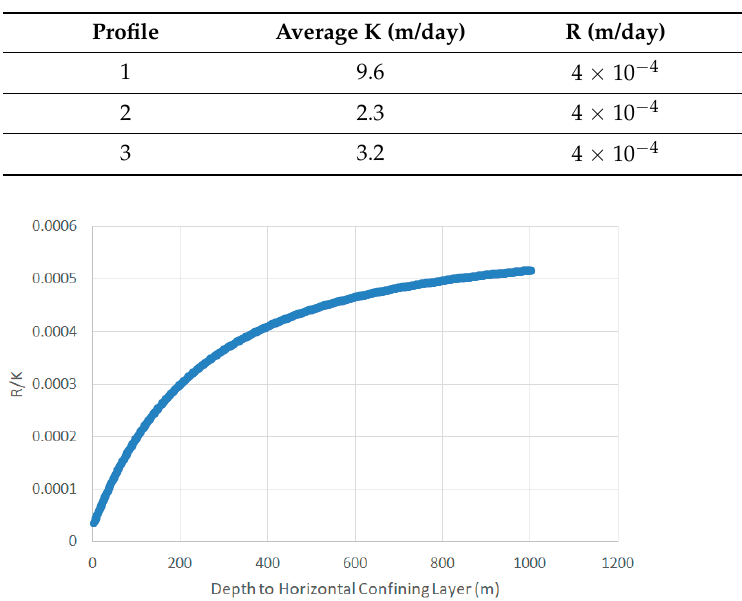
horizontal confining layer (D). Adjusted depths were calculated by changing the input D value until